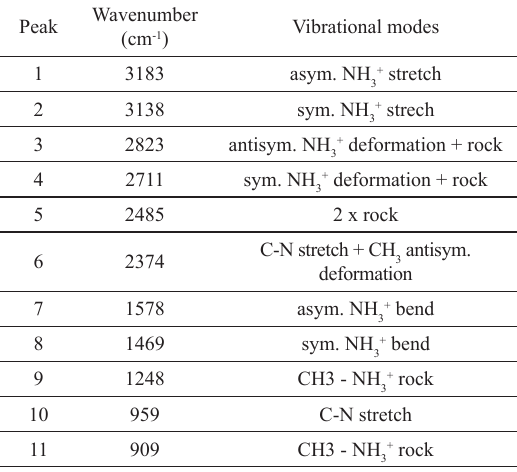
NH PbI perovskite 3 3 3